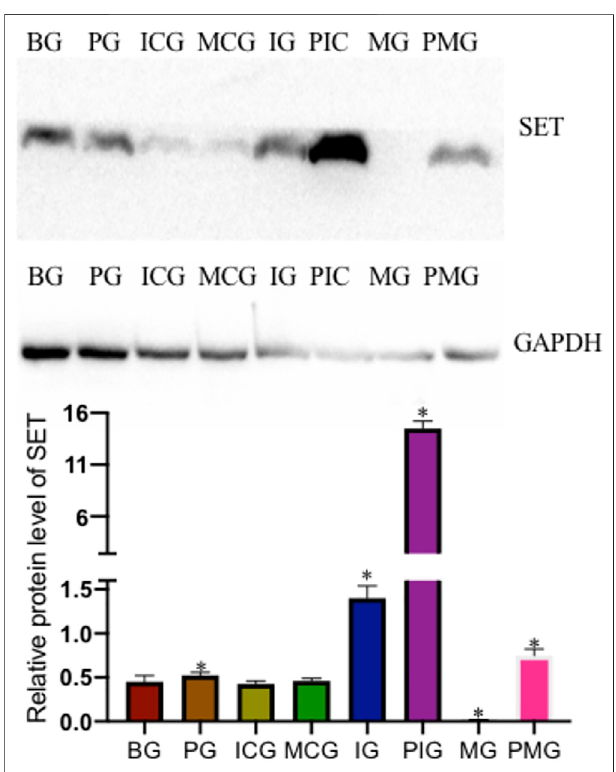
FIGURE 3 | Relative protein level of SET among different groups. n = 3 for each group. * p < 0.05 vs. the BG